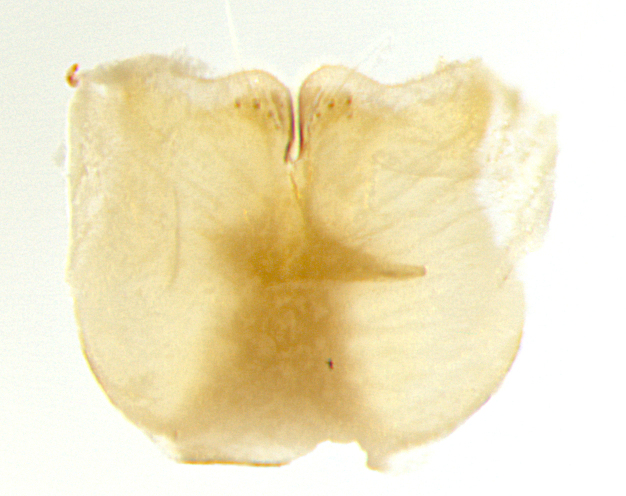
sternite 5, ventral view.